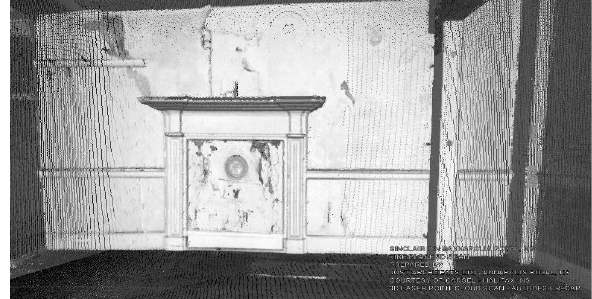
Figure 2: Interior of the Painted Room, 2014, prior to “reveals”. Source: Ann Shaftel